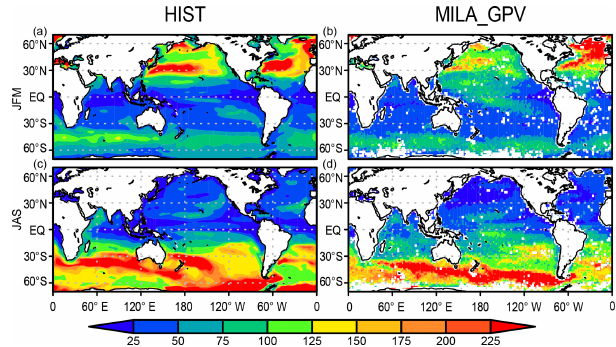
Figure 7. Mixed-layer depth (m) in the HIST simulation presented as a 2000–2010 climatology and comparison with the MILA_GPV dataset (Hosoda et al., 2010) for (a, b) JFM and (c, d) JAS